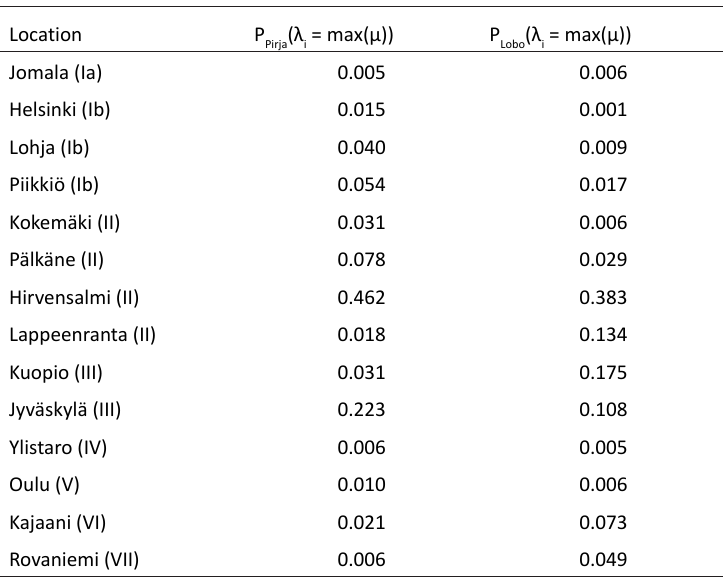
Table 2. The probability that the expected number of “infection days” per year